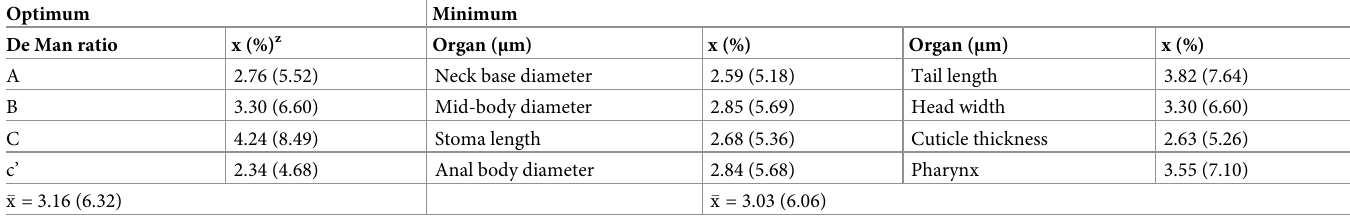
Table 1. Extrema for Nemafric-BL phytonematicide concentration to generate optimum/minimum morphometrics for organs in Steinernema feltiae infective juveniles.